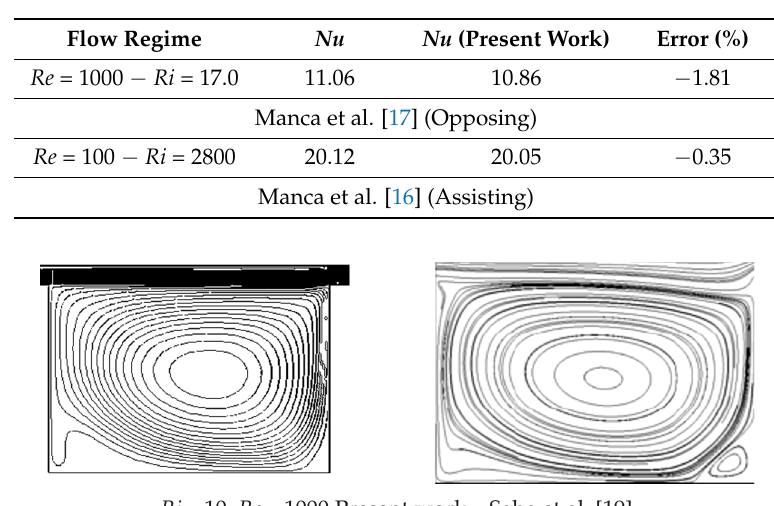
Figure 3. Isotherms—Streamlines present work—( L / D = 1.5).